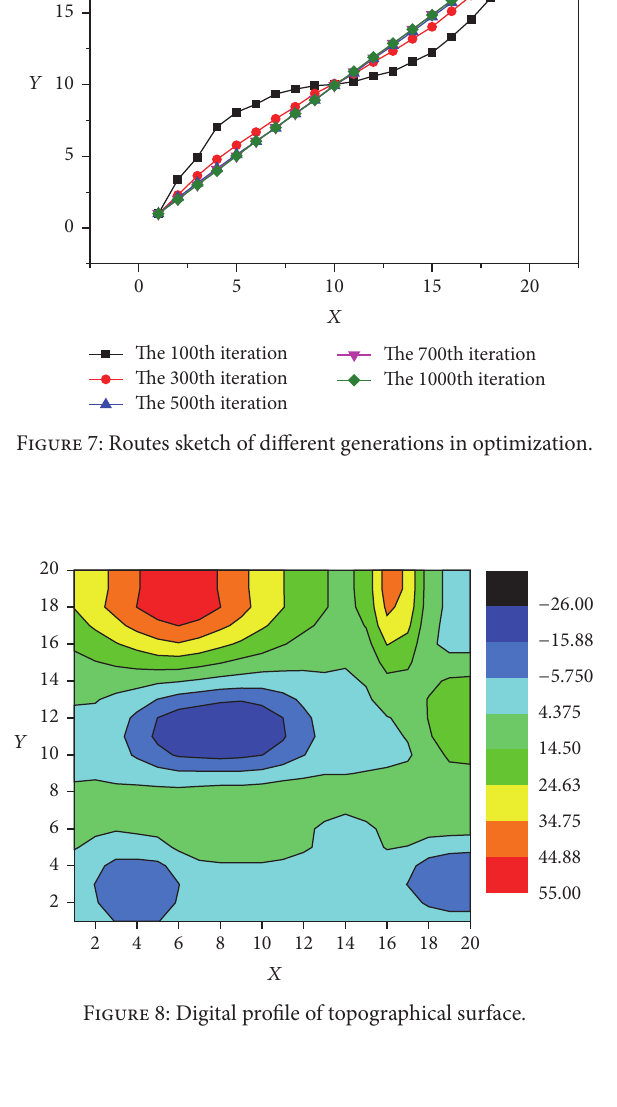
Table 2: Best result obtained from ssGA and gGA.